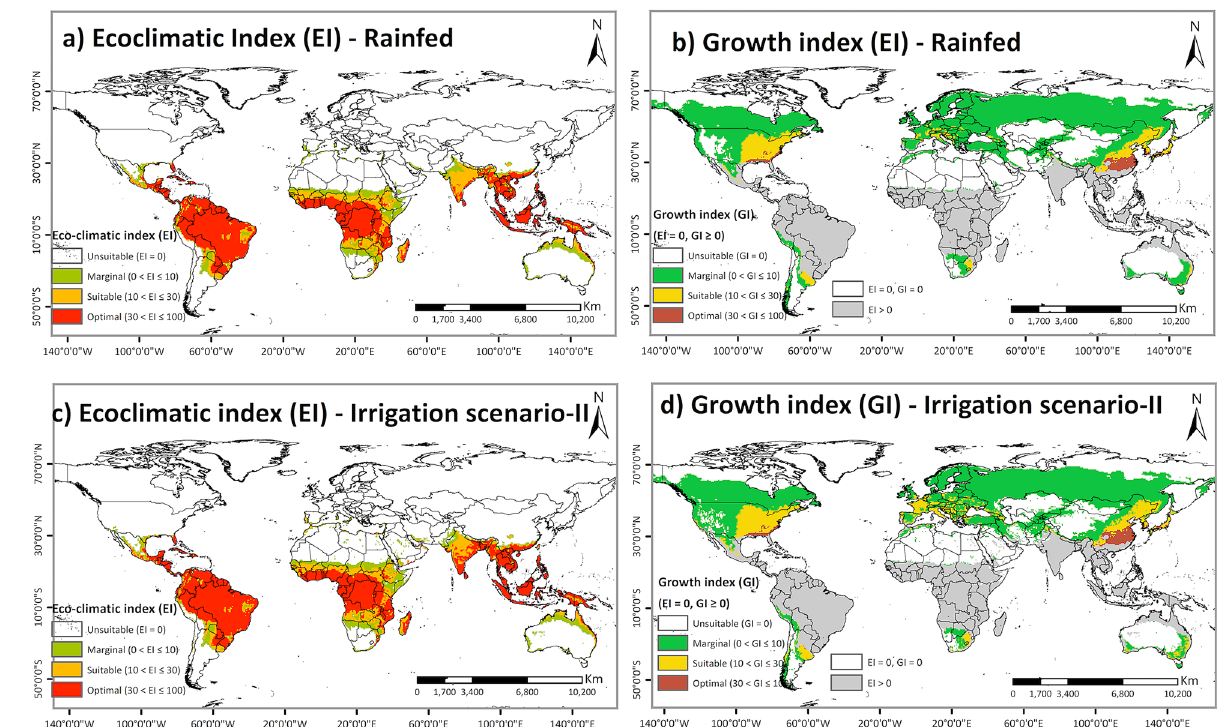
Figure 2. The projected global climate suitability for FAW population establishment and seasonal population growth under historic climate using CLIMEX. ( a ) Projected areas for year-round population establishment under rainfed condition. ( b ) Growth index (GI) for seasonal population growth under rainfed condition. ( c ) Projected areas for year-round population establishment under irrigation scenario II. ( d ) Growth index (GI) for seasonal population growth under irrigation scenario II. Areas with EI > 0 support FAW year-round population establishment, areas with EI = 0 but GI > 0 support FAW seasonal population growth and areas with EI = 0 and GI = 0 are unsuitable for FAW survival. ArcMap 10.8 (https:// deskt op. arcgis. com/ en/